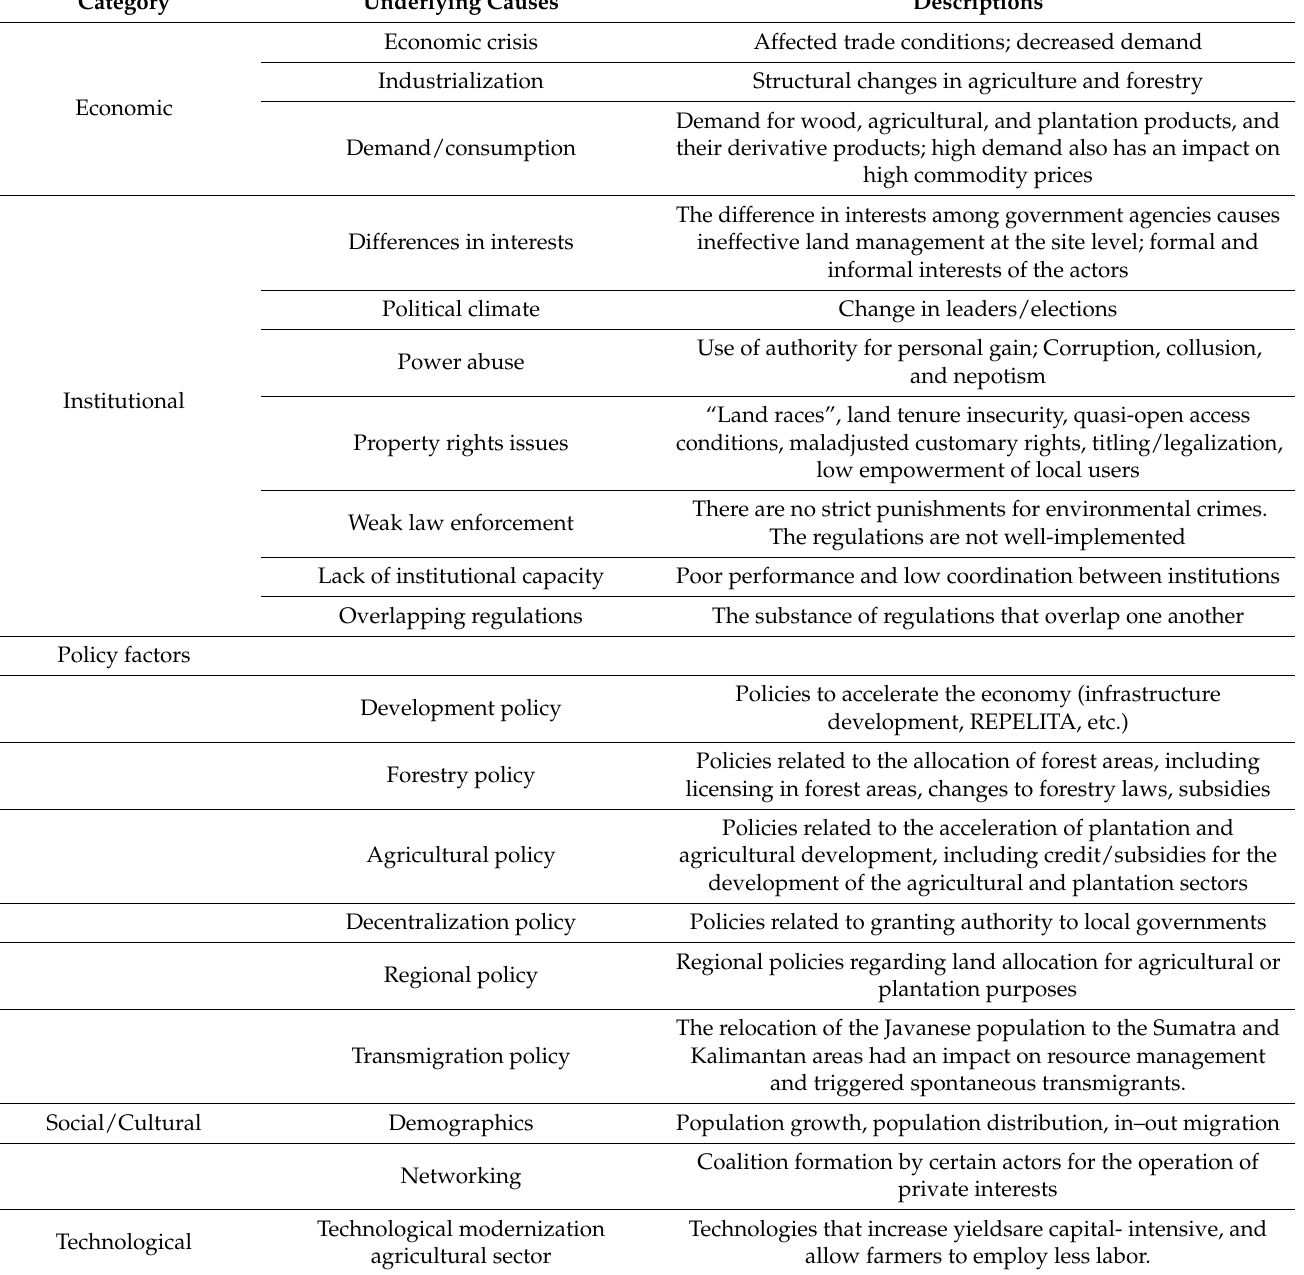
Table A2. Underlying causes of land change in Sumatra and